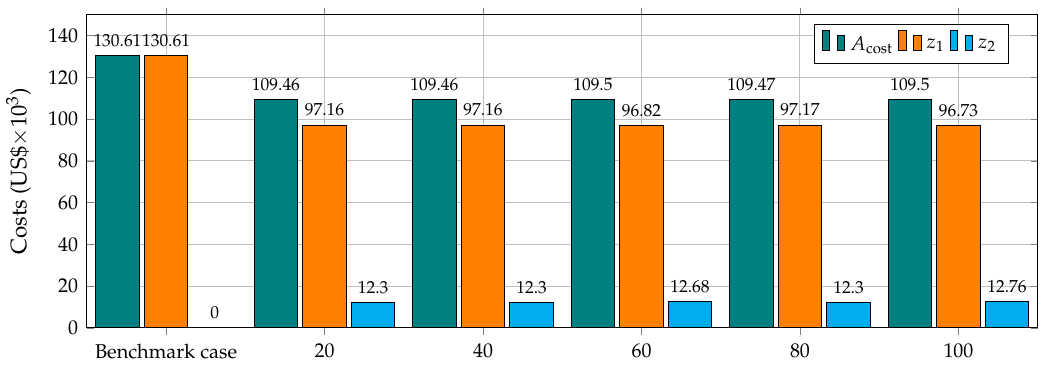
Figure 5. Discriminated costs considering different population sizes for the